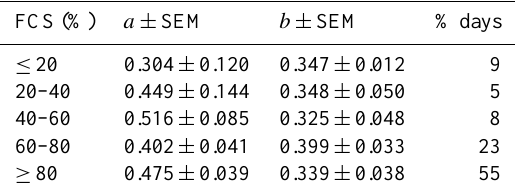
Table 5. Coefficients a and b between 1992 and 2000 at IZO as a function of the fraction of clear-sky values (FCS). SEM is the standard error of the